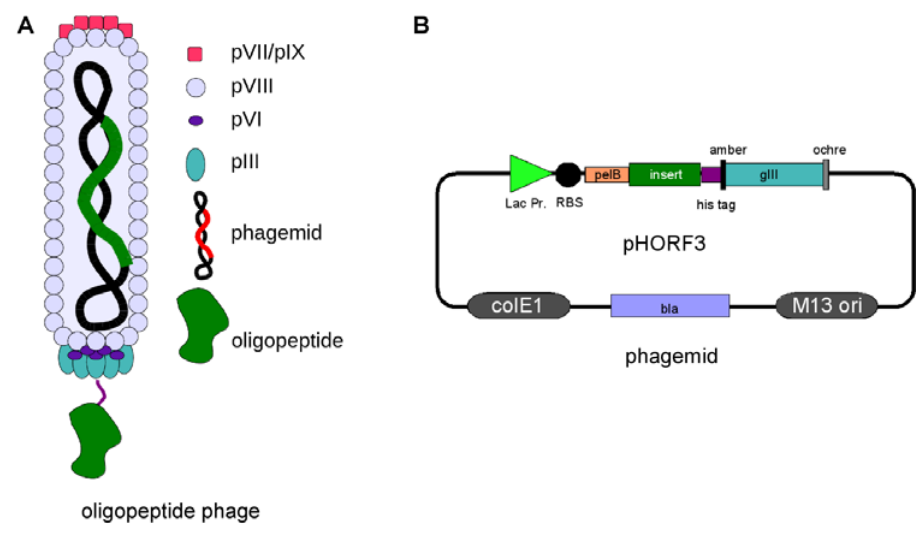
Figure 1. ( a ). Oligopeptide display on phage. pIII=phage protein III. ( b ).